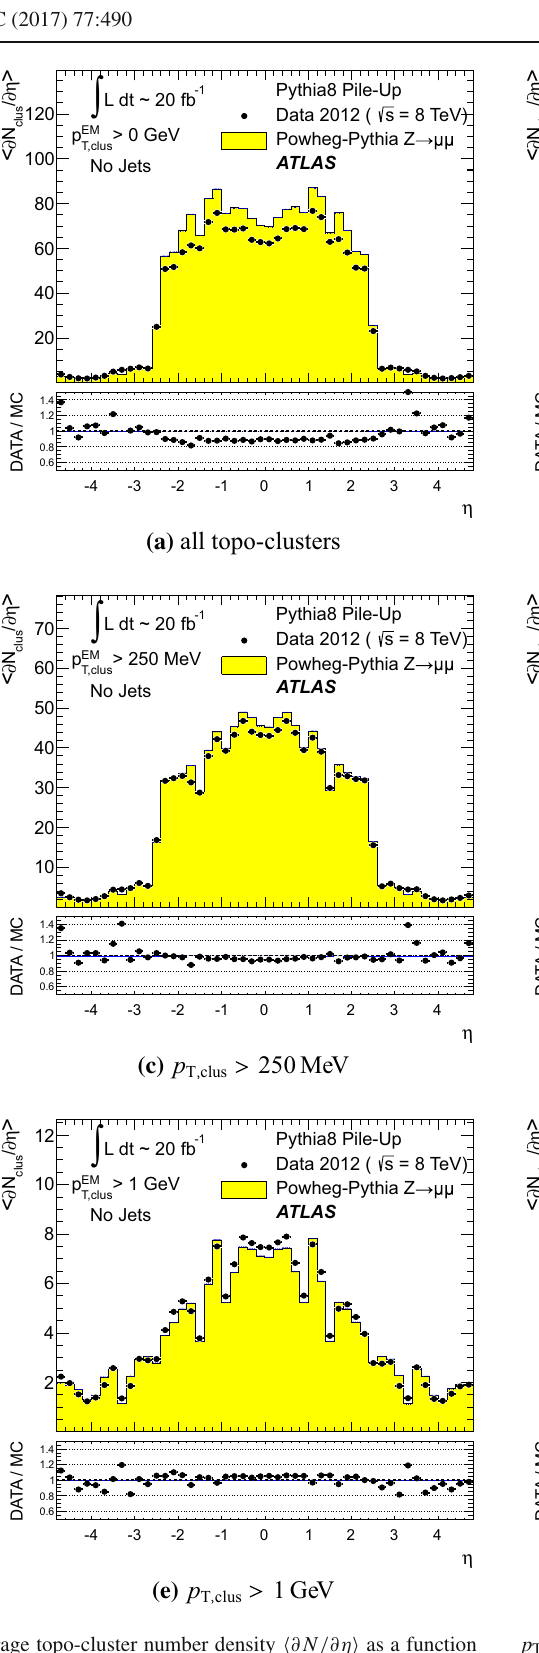
Fig. 25 Average topo-cluster number density (cid:7) ∂ N /∂η (cid:8) as a function p T > 20GeV in data and MC simulations. The corresponding data-to- > p of η clus , for clusters with p EM MC simulation ratios are shown below each T , min , for various p T , min values. T , clus Results are obtained from a 2012 Z → μμ sample without jets with